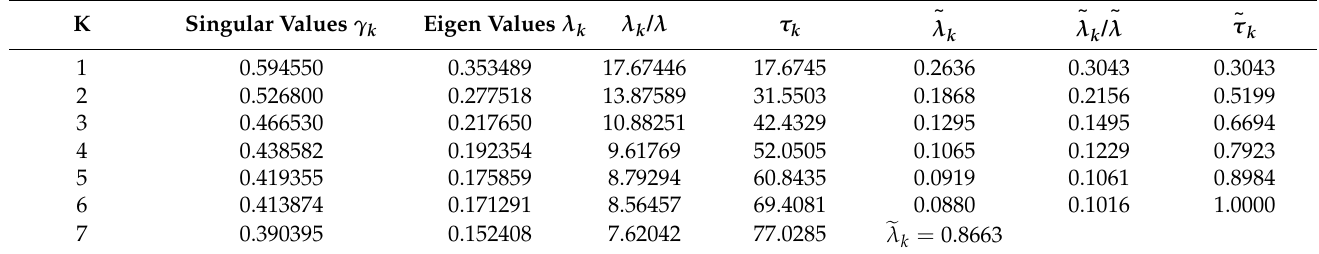
Figure 5. Eigenvalue—“elbow” criterion. Table 8. Singular values and eigenvalues together with the degree of explanation of the total inertia in the original and modified versions.